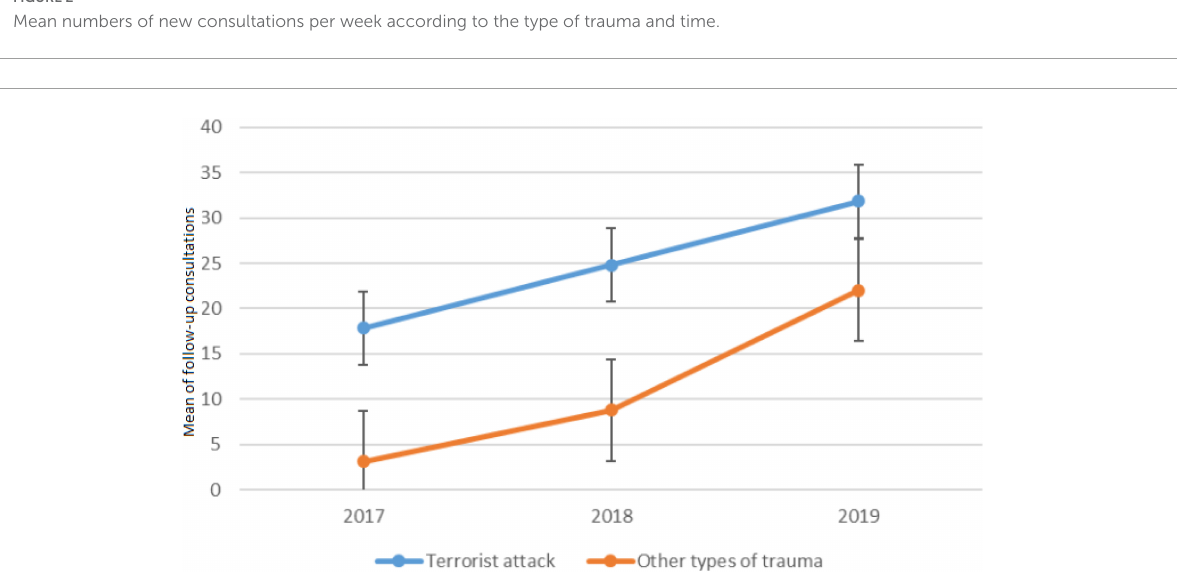
FIGURE2 Mean numbers of new consultations per week according to the type of trauma and time.